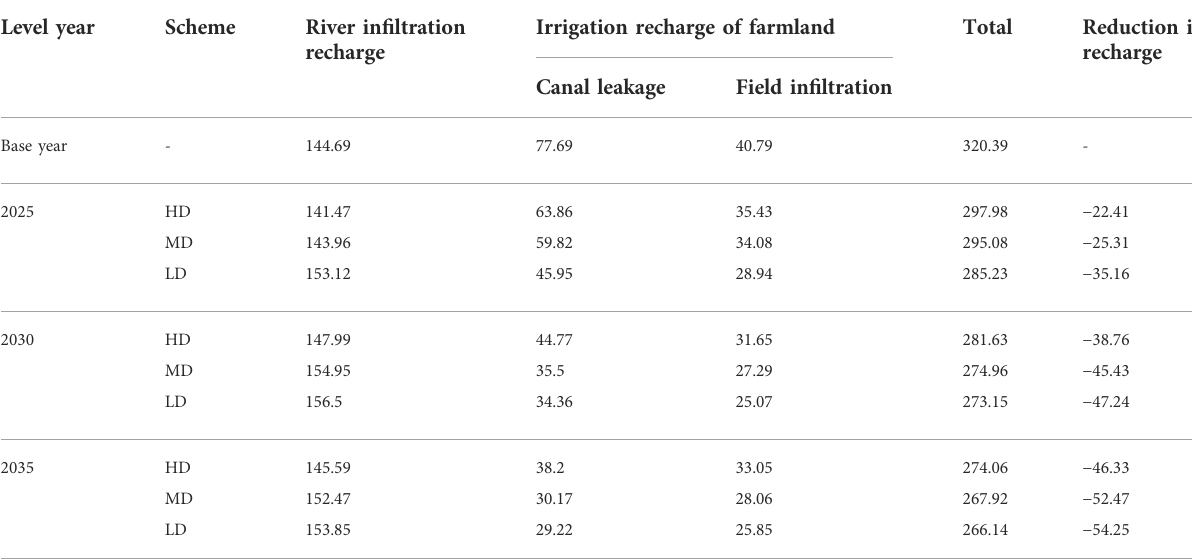
TABLE 5 Groundwater recharge in Jinghe County (unit: 10 6 m 3